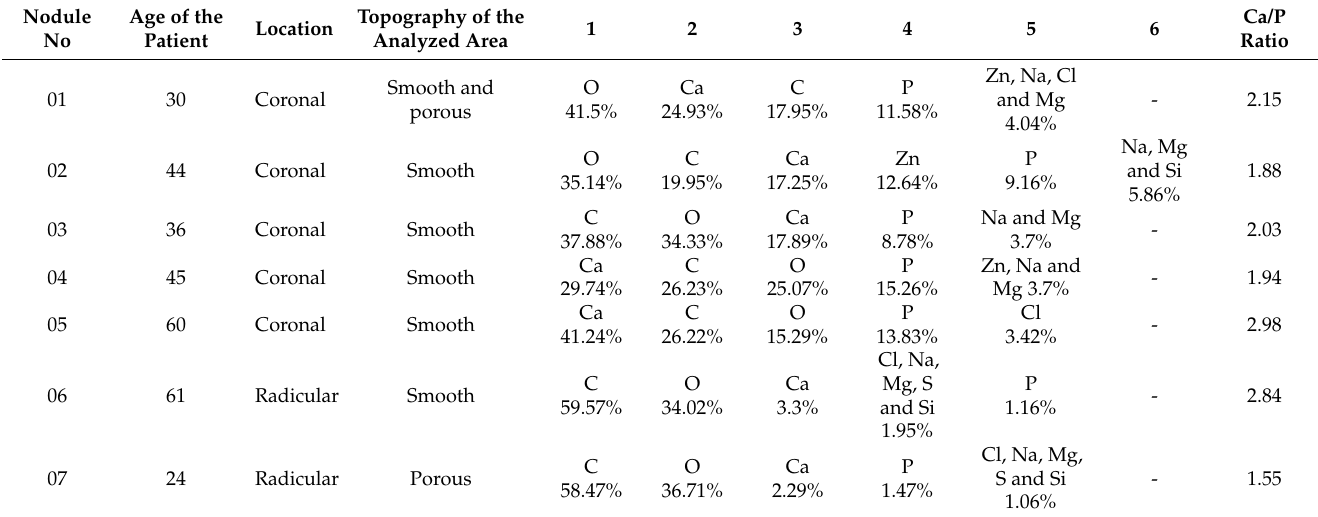
Table 2. Chemical composition of evaluated pulp stones dependent on their topography and